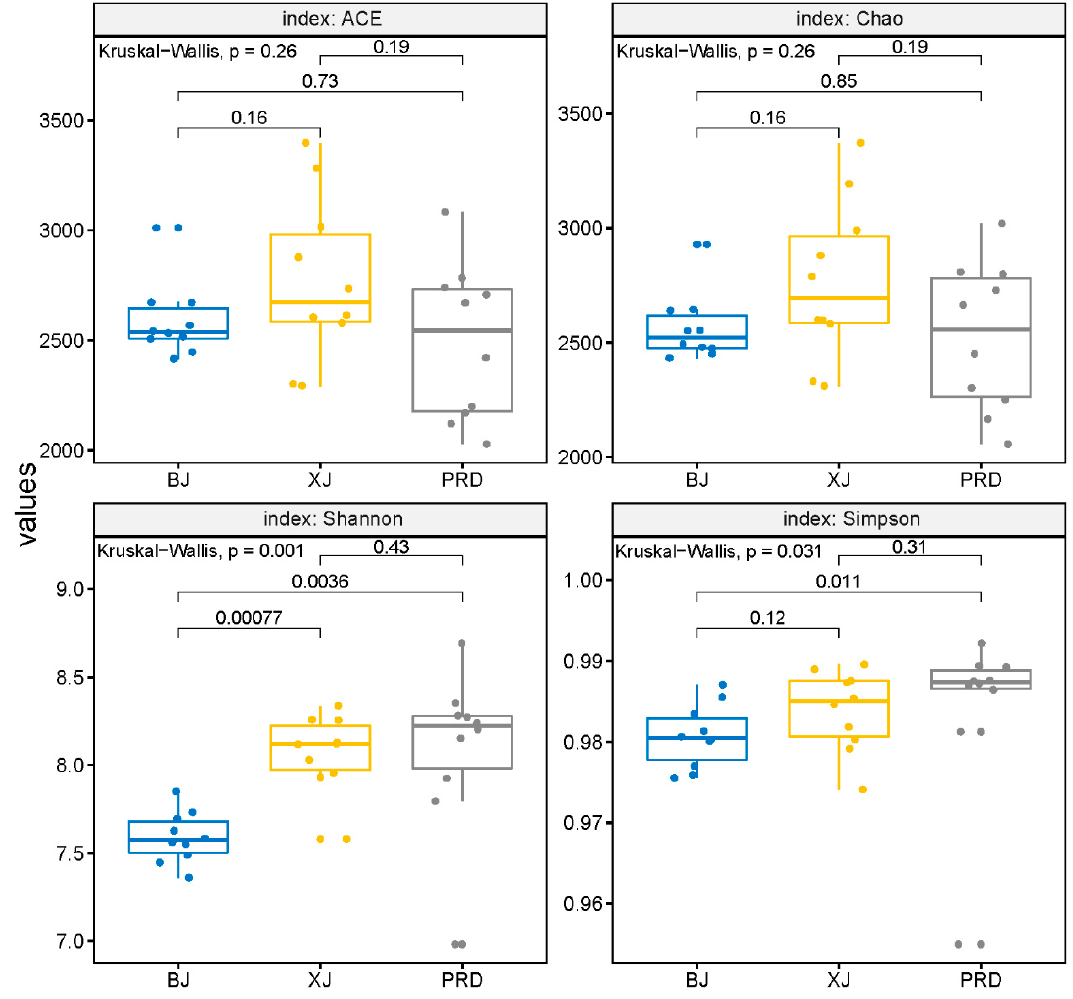
Figure 4. Comparison of alpha diversities, including Abundance-based Coverage Estimator (ACE), Chao, and Shannon and Simpson indices among different Pearl River tributaries. BJ, Beijiang; XJ, Xijiang; and PRD, Pearl River Delta.